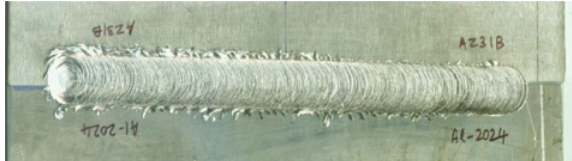
Figure 5: Surface morphology of the FSW coupon of Al alloy to Mg alloy, obtained by interface offset varying welding with